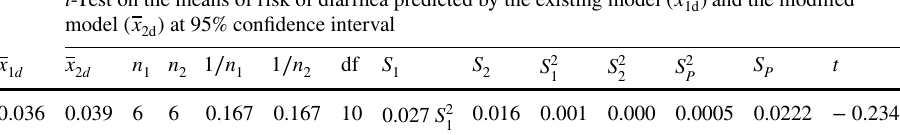
ẍ 2d = mean risk of diarrhea predicted by modified